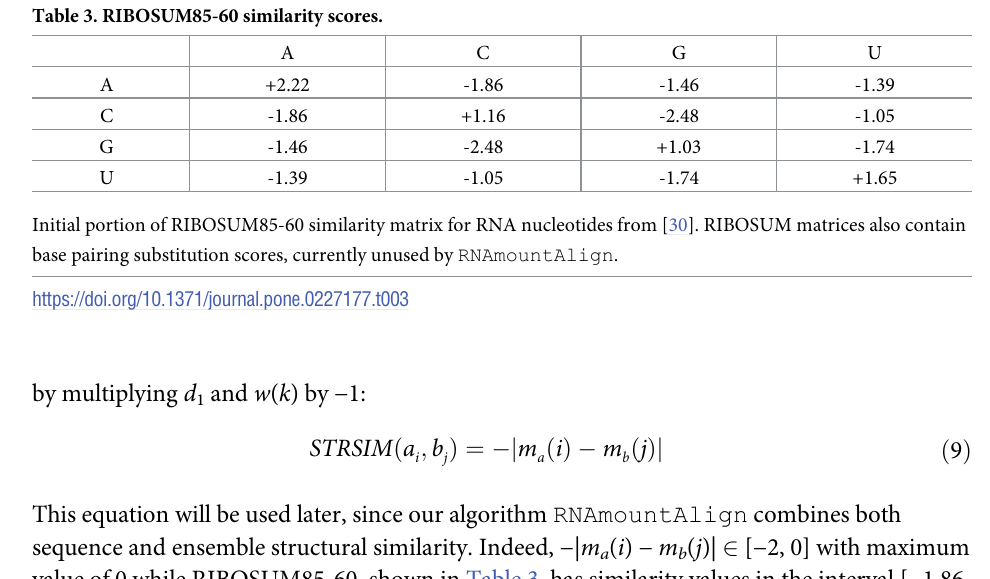
Table 3. RIBOSUM85-60 similarity scores.